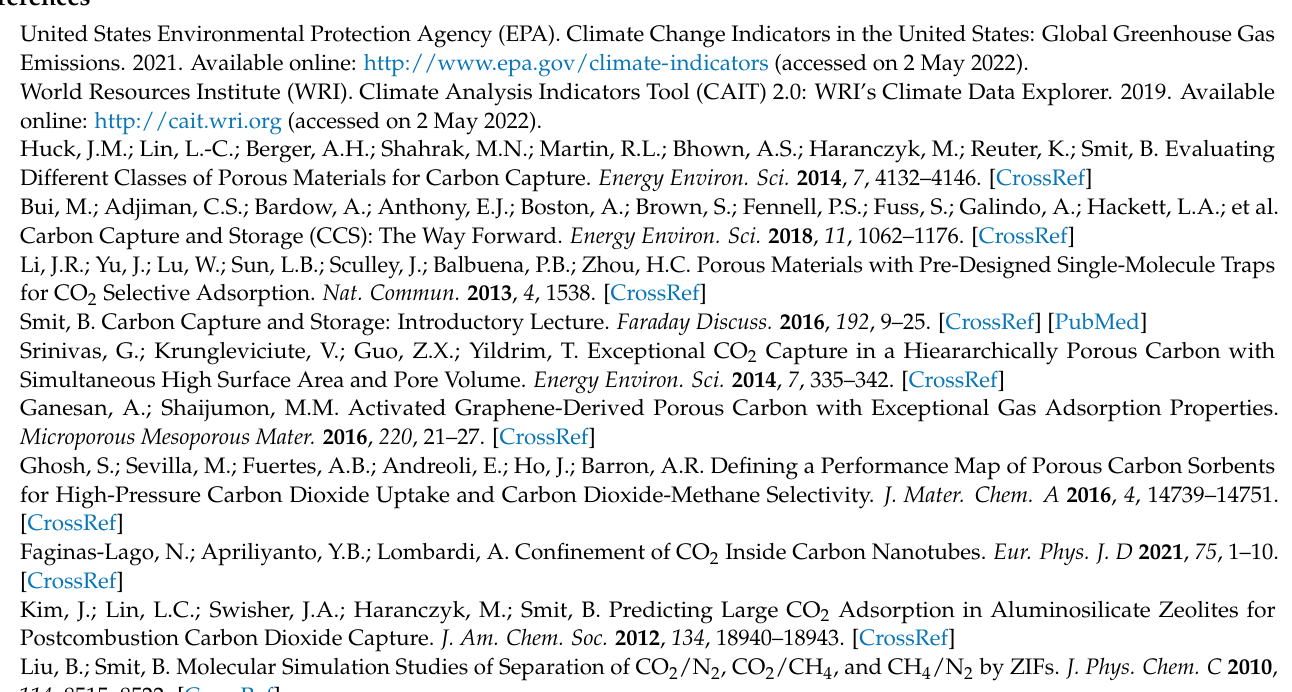
Tables S15–S17: Adsorption coefficient in single layer, bilayer, and trilayer systems, respectively; Table S18: Interlayer adsorption selectivity of CO 2 , N 2 , H 2 O gaseous